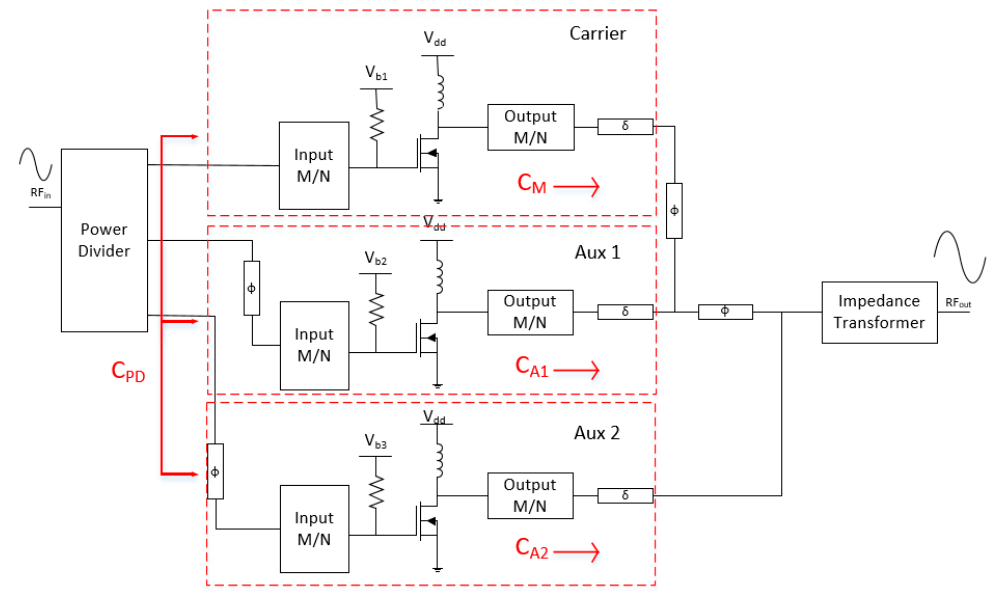
Figure 2. Complexity paths for three ‐ way DPA. The main and two auxiliary paths are in parallel.